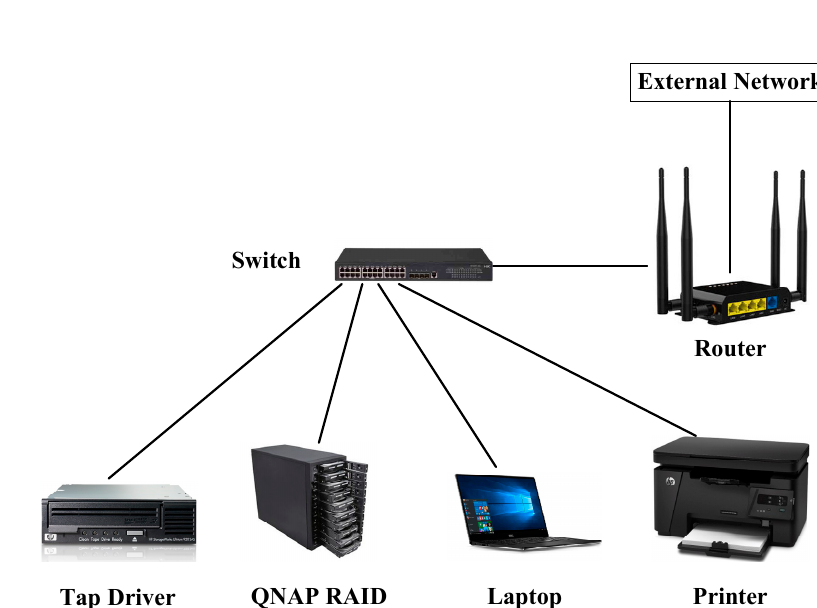
Figure 3. Field data processing, quality control and archiving system. Remote Sens. 2020 , 12 , x FOR PEER REVIEW